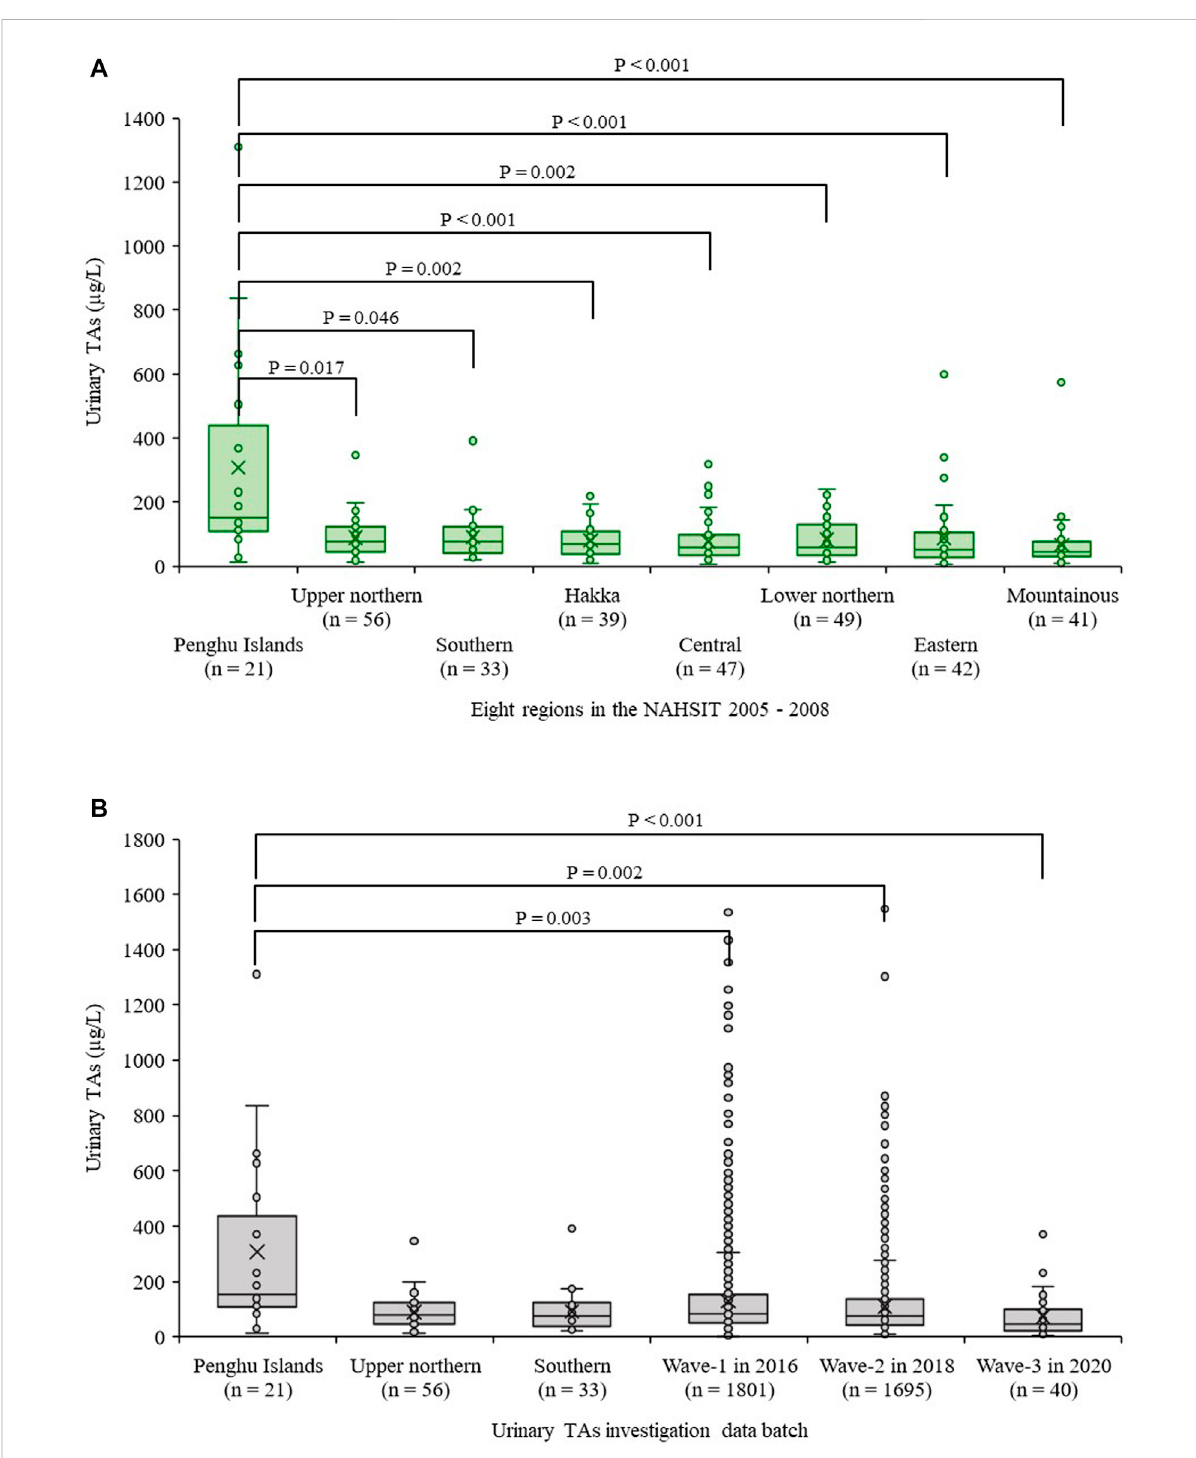
FIGURE 3 Comparisonsofurinarytotalarsenic(TAs)levelsinpeoplefromdifferentregionsofTaiwan; (A) DatasolelyfromtheNutritionandHealthSurvey inTaiwanduringthesurveyof2005-2008(NAHSIT2005-8); (B) DistributionsofurinaryTAslevelsfromsixtownshipsin2016,2018,and2020 vs. the top three highest TAs levels of NAHSIT